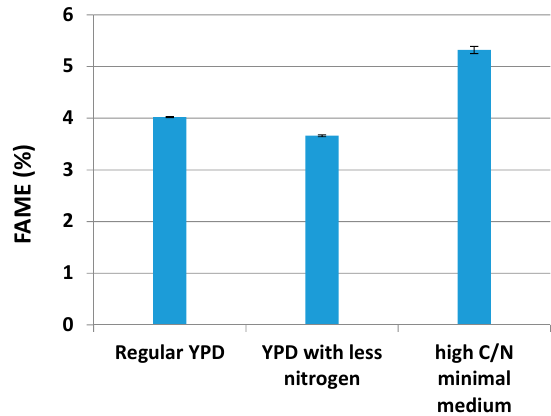
Figure 2. Lipid production by Yarrowia lipolytica in YPD and minimal media with different C/N ratios. Total lipid content in biomass was expressed as fatty acid methyl esters (FAME). Data show mean value with standard deviation from technical triplicate samples of one representative experiment. The difference among three conditions is significant based on One Way Analysis of Variance (ANOVA) with p ‐ value less than 0.001 for all comparisons.